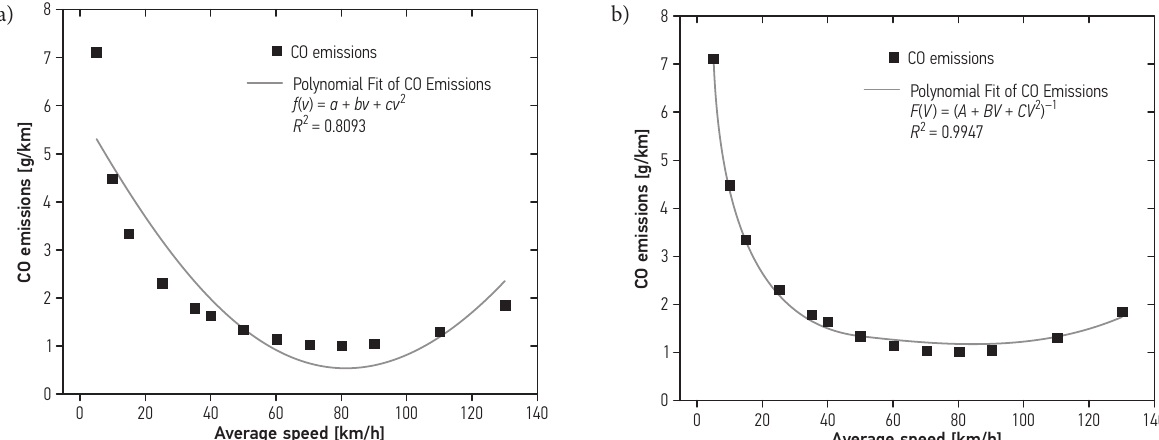
Fig. 7. Average speed dependant CO emissions and fitting